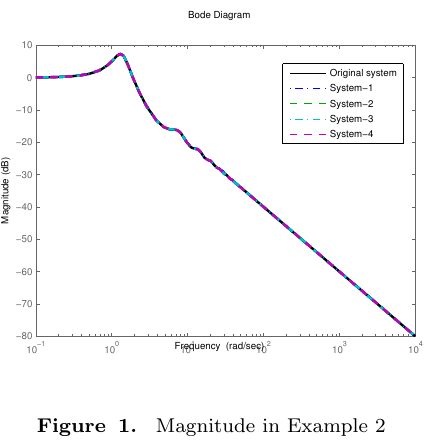
Figure 1. Magnitude in Example 2